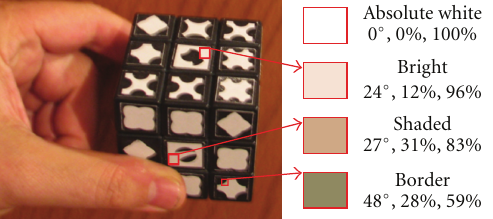
Table 2: Determining tilt interaction speed.